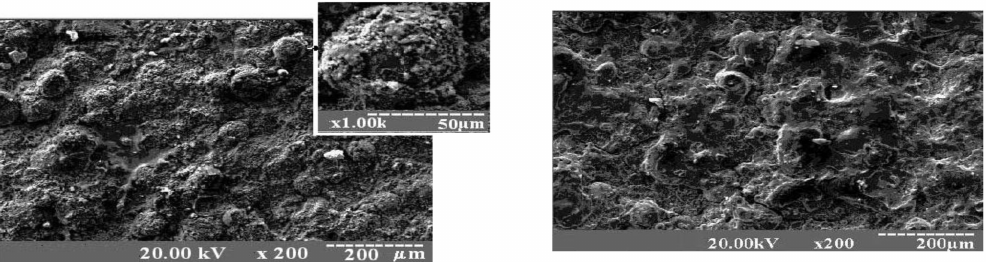
Figure 6. Surface